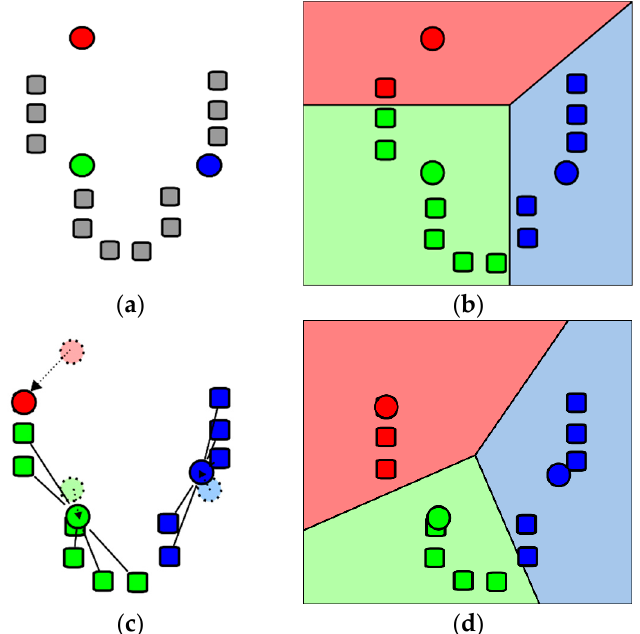
Figure 3. A simple demonstration of the k-means clustering algorithm [36] with the following procedures: ( a ) initialization, ( b ) partition, ( c ) new centroid, and ( d ) stopping criterion.